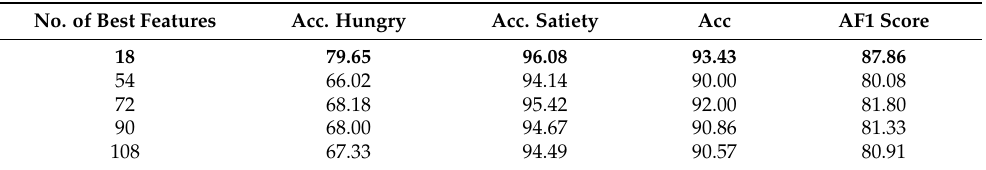
Table 7. Results of the classification of hunger and satiety using RF classifier based on the best features selected with feature importance